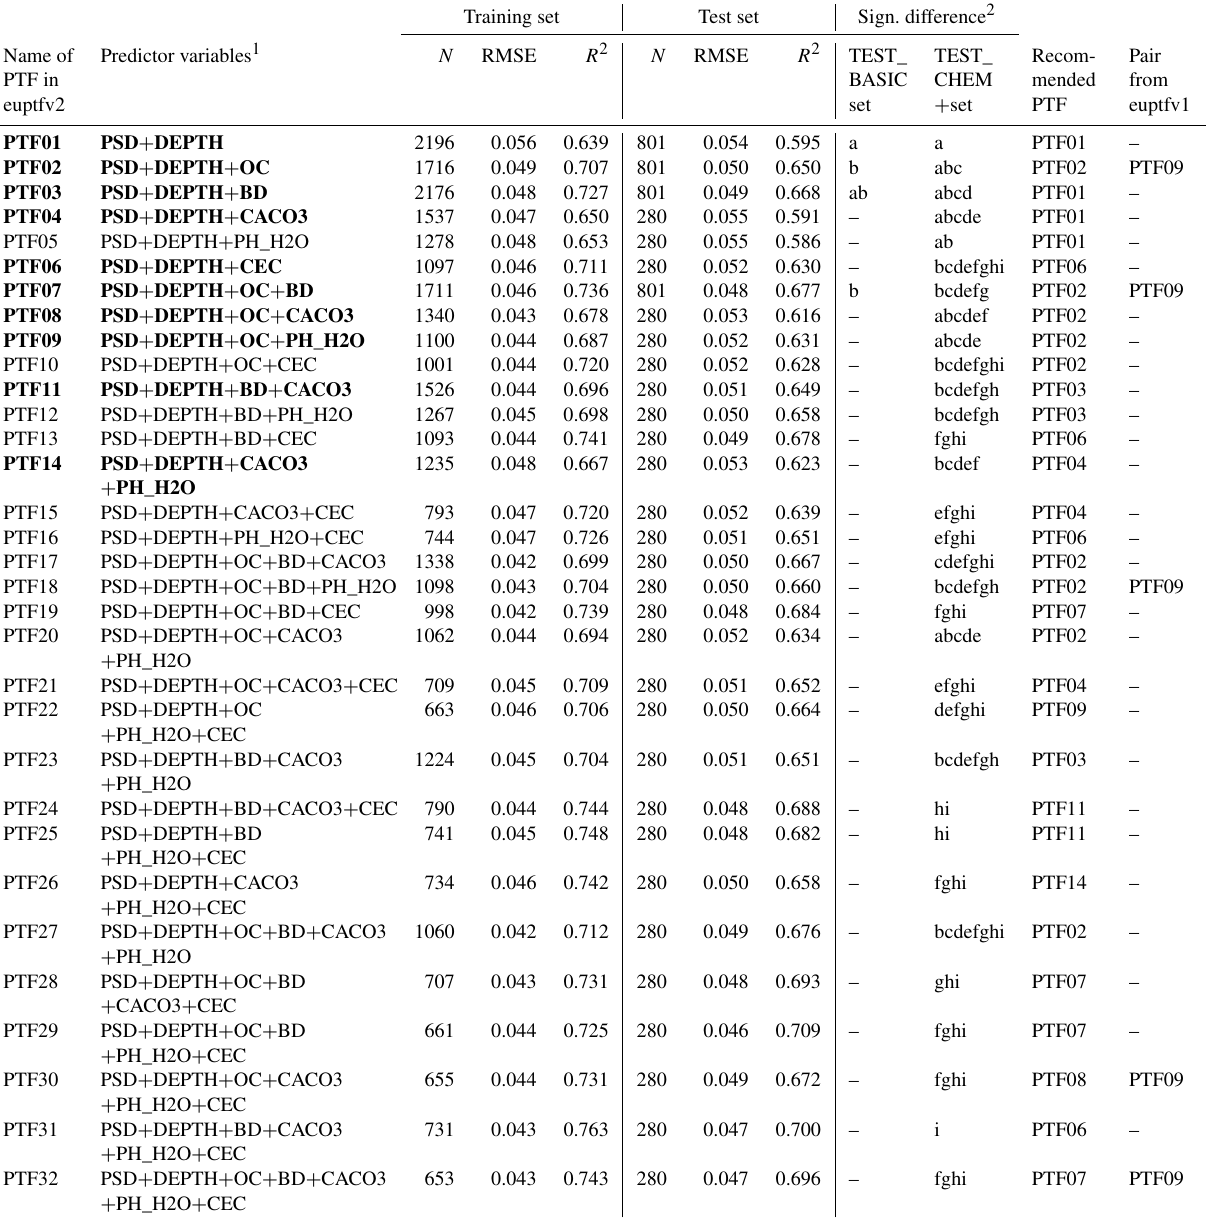
Table 4. Performance of pedotransfer functions (PTFs) by input combination on training and test datasets to predict water content at − 330cm matric potential head, field capacity (FC). N : number of samples, RMSE: root mean square error (cm 3 cm − 3 ), and R 2 : determination coefficient, TEST_BASIC: samples with measured PSD, DEPTH, OC and BD; TEST_CHEM + : samples with measured PSD, DEPTH, OC, BD, CACO3, PH_H2O and CEC. Recommended PTFs are highlighted in bold.